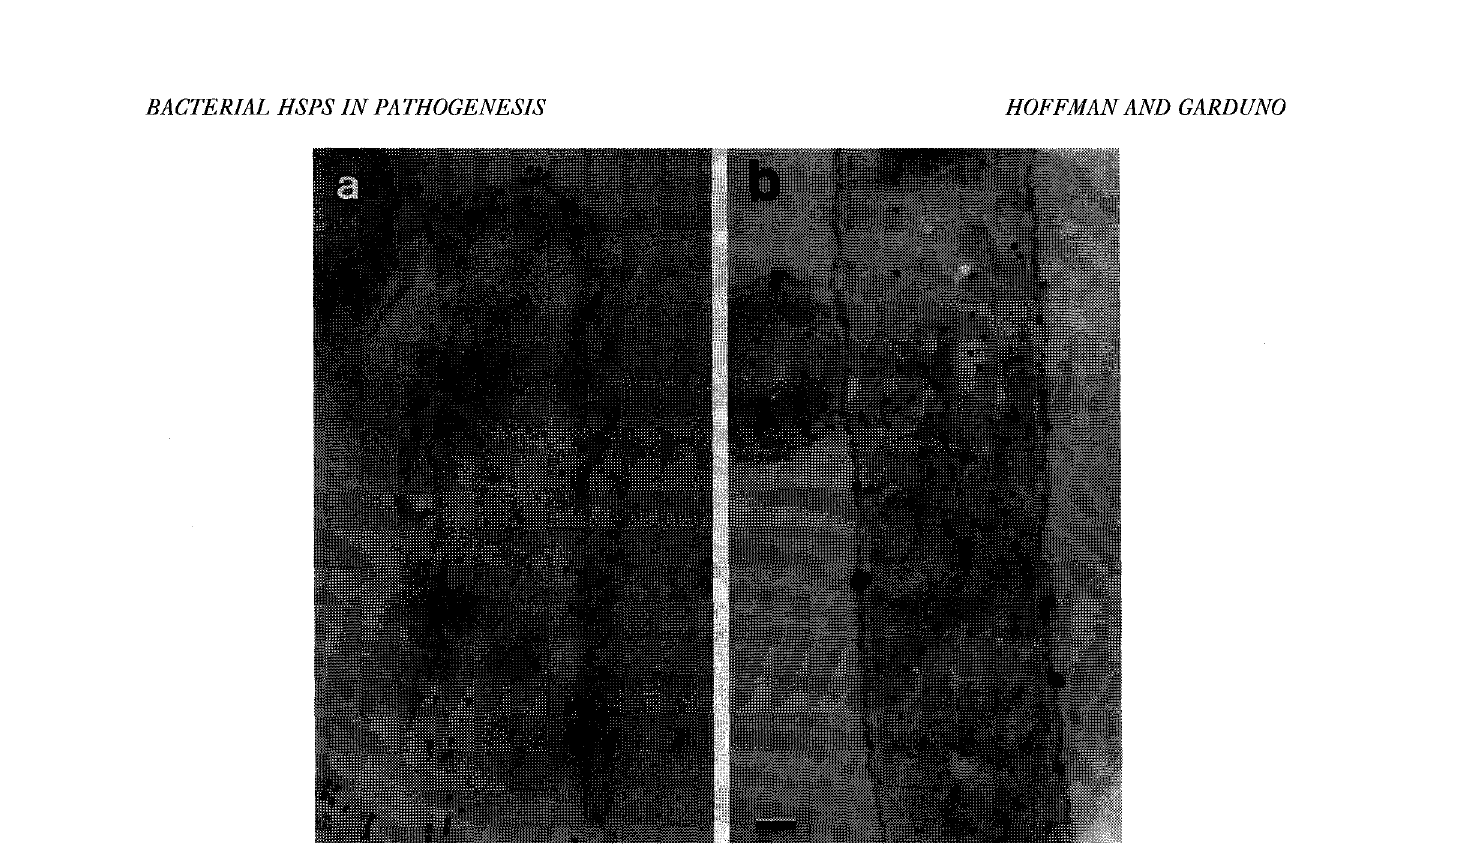
Fig. I. Immunolocalization of Hsp60 in L. pneumophila (a) and E. coli expressing recombinant L. pneumophila Hsp60 from pSHI6 (b). Bar indicates 0.1 mm for both